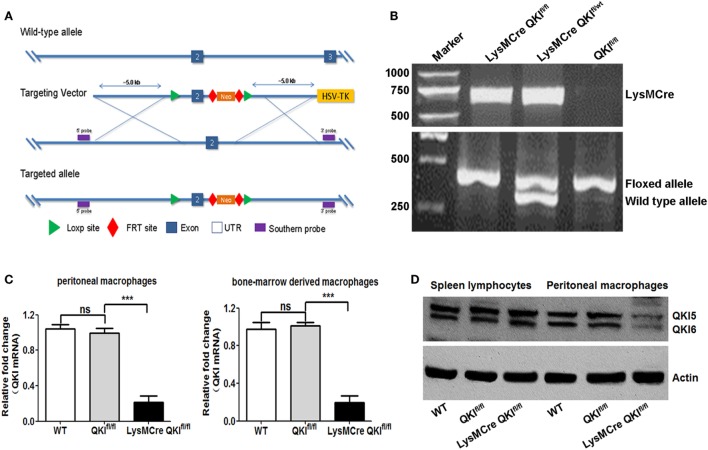
Generation and characterization of myeloid-specific quaking (QKI)-deficient mice. (A) The targeting strategy of QKI LoxP mice is shown. (B) Total genomic DNA from mouse tail tissues was isolated and subjected to PCR analysis using a site-specific primer. The 700-bp product indicates the presence of the cre allele. The 410-bp product indicates the presence of the QKI-floxed allele, while the 370-bp product indicates the presence of the wild-type (WT) allele. (C) WT, QKIfl/fl, and LysMCre QKIfl/fl mouse thioglycollate-induced peritoneal macrophages and bone marrow-derived macrophages were analyzed for QKI mRNA expression by quantitative PCR. Actin was used as the housekeeping gene. Levels of QKI in WT mice were set as one. Each group included 10 mice. All the bars represent the mean of measurements from three independent experiments, and the error bars indicate ±SEM. (D) Peritoneal macrophages and spleen lymphocytes from WT, QKIfl/fl, and LysMCre QKIfl/fl mouse were isolated and lysed. Total cell lysates were subjected to western blot analysis using rabbit polyclonal anti-QKI antibody. Actin was used as the internal control. ***p < 0.001.